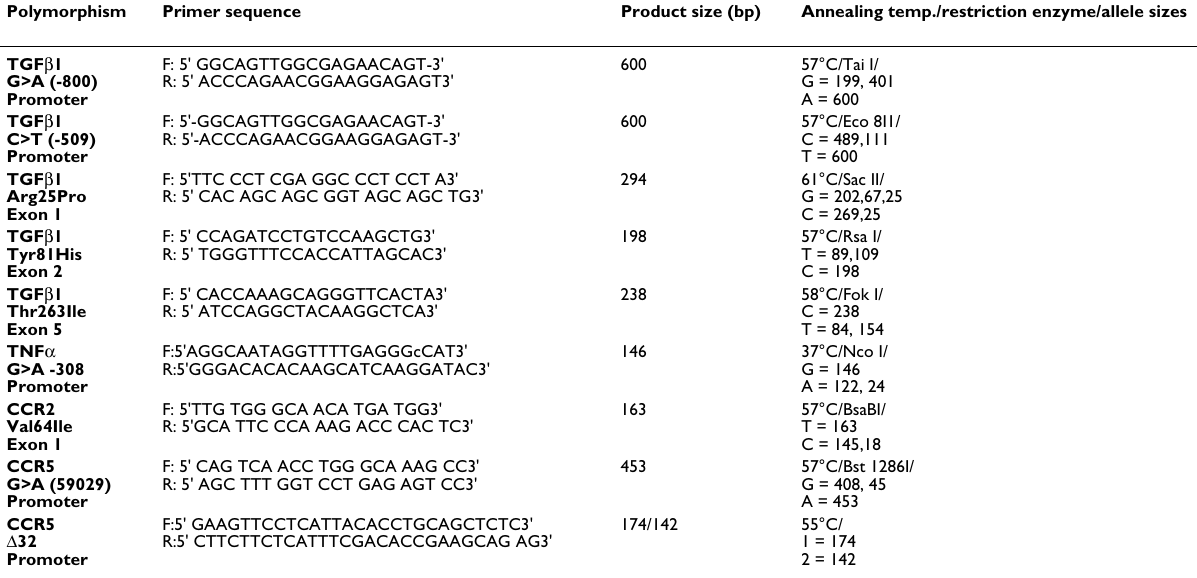
Table 1: SNPs in TGF β 1, TNF α , CCR2 and CCR5 genes, their location, primer sequences, PCR conditions and restriction enzyme with product sizes. Polymorphism Primer sequence Product size (bp) Annealing temp./restriction enzyme/allele